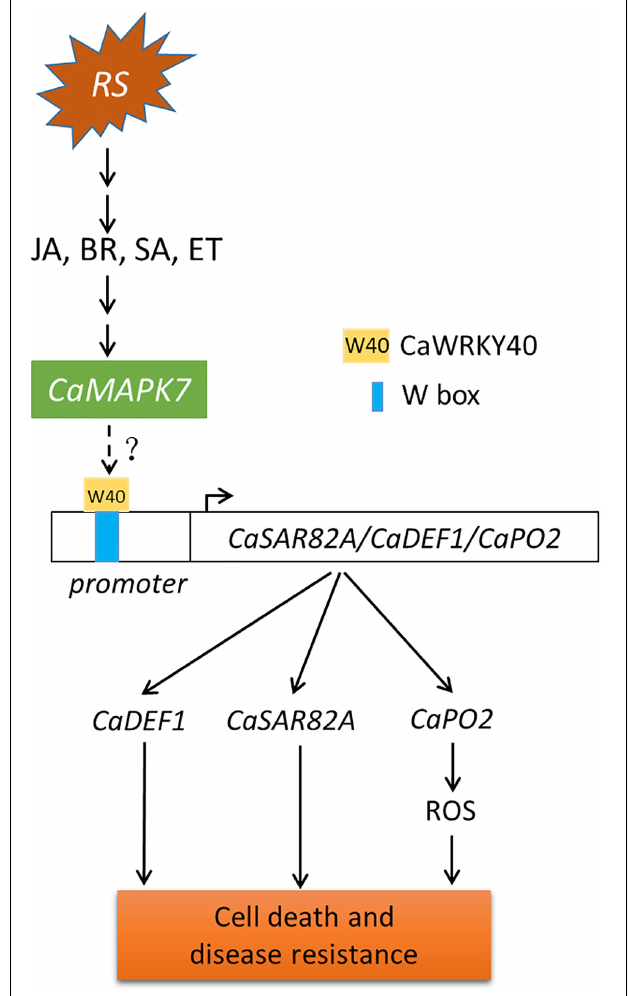
FIGURE 9 | Proposed model of CaMAPK7 in response to inoculation with Ralstonia solanacearum in pepper plants. The pepper CaMAPK7 has a positive effect on the trans-activation of CaWRKY40, which regulates the expression of defense-associated marker genes, ultimately leading to cell death and disease resistance. Arrows indicate positive regulation, and dotted ends denote unknown regulation. RS, Ralstonia solanacearum .